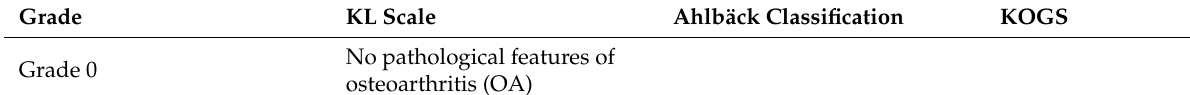
Table 1. Comparison of the original definitions of the Kellgren–Lawrence (KL) scale, Ahlbäck clasScheme 20.